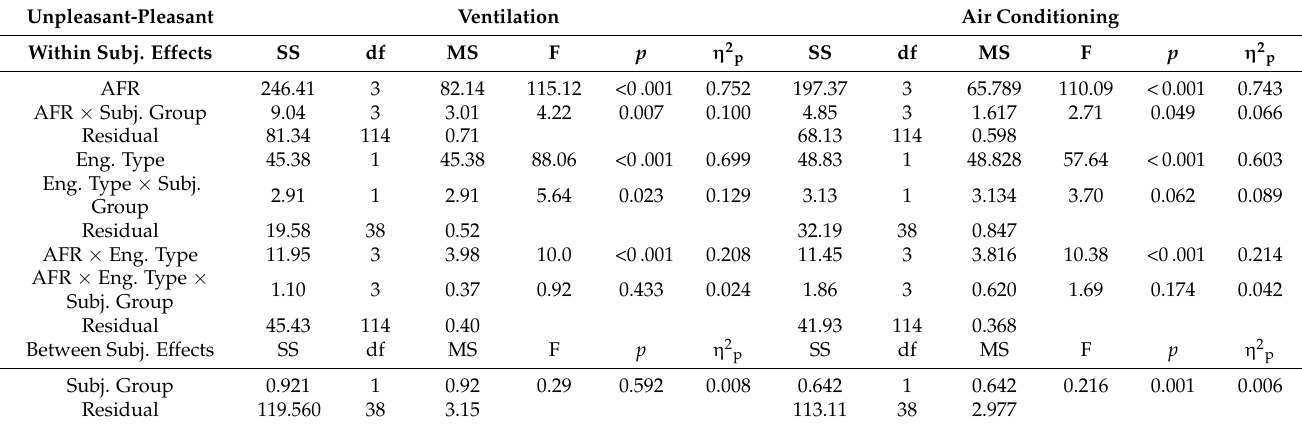
Table 4. ANOVA results for Unpleasant-Pleasant